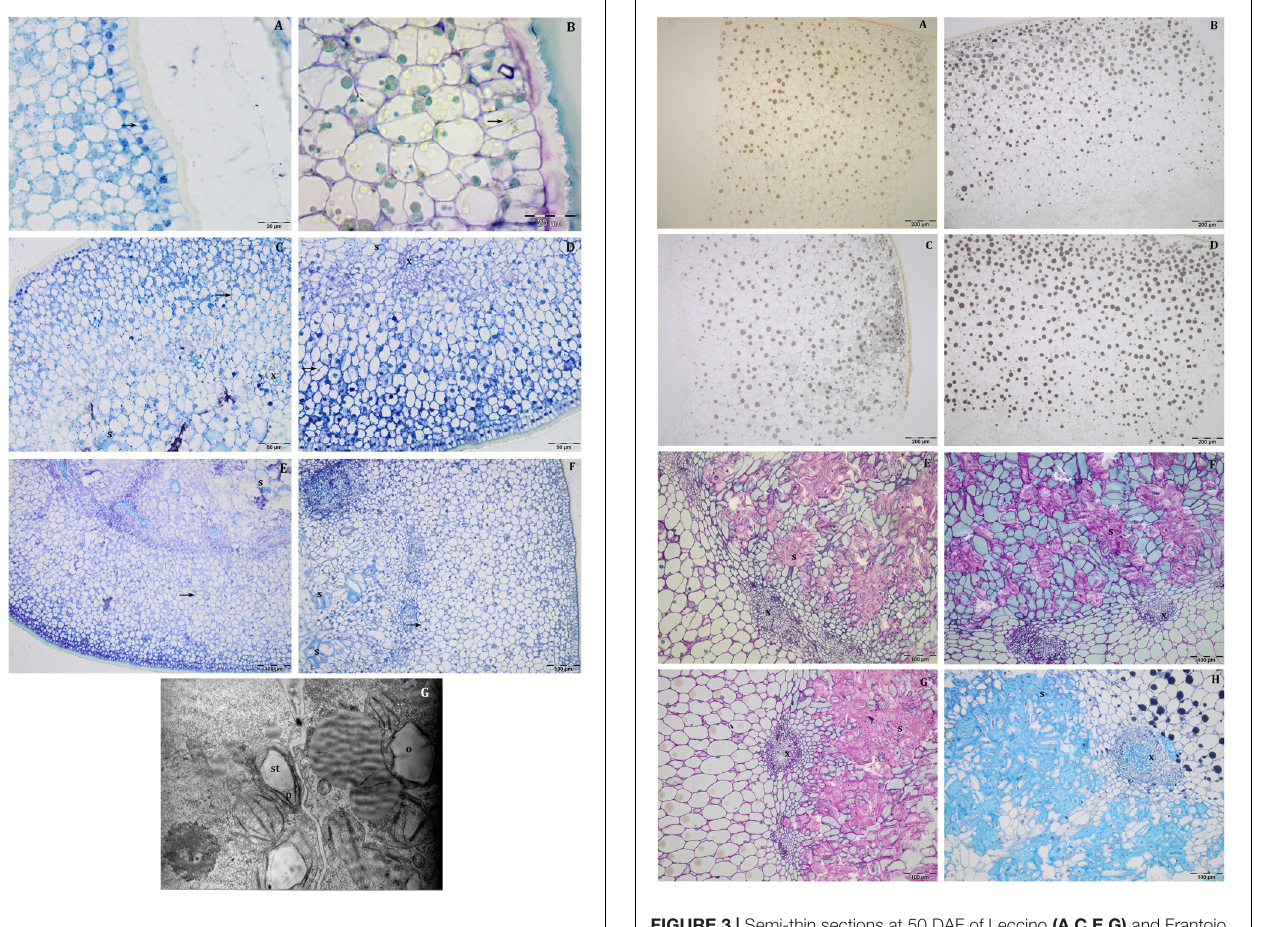
FIGURE 2 | Semi-thin sections at 14 DAF (A–D) and 21 DAF (E–G) of Leccino (A,C,E) and Frantoio (B,D,F) olive fruits. At 14 DAF, in the external epidermis, anticlinal divisions (black arrow) were detected (A,B) , while, in the inner portion of pericarp (C,D) , individual sclerified stone cells (s) and xylem cells (x) were differentiated. At 21 DAF mitotic divisions were yet evident ( E,F , black arrows), while in the endocarp sclerified stone cells (s) were detected more frequently in Frantoio (F) than in Leccino fruits (E) . (B) is stained with PAS reaction, while the other figures are stained with toluidine blue. (G) Thin section of pericarp of Frantoio light fruit at 21 DAF: the presence of primary starch (st) in the plastid (p), and the oil drops (o) were evident.